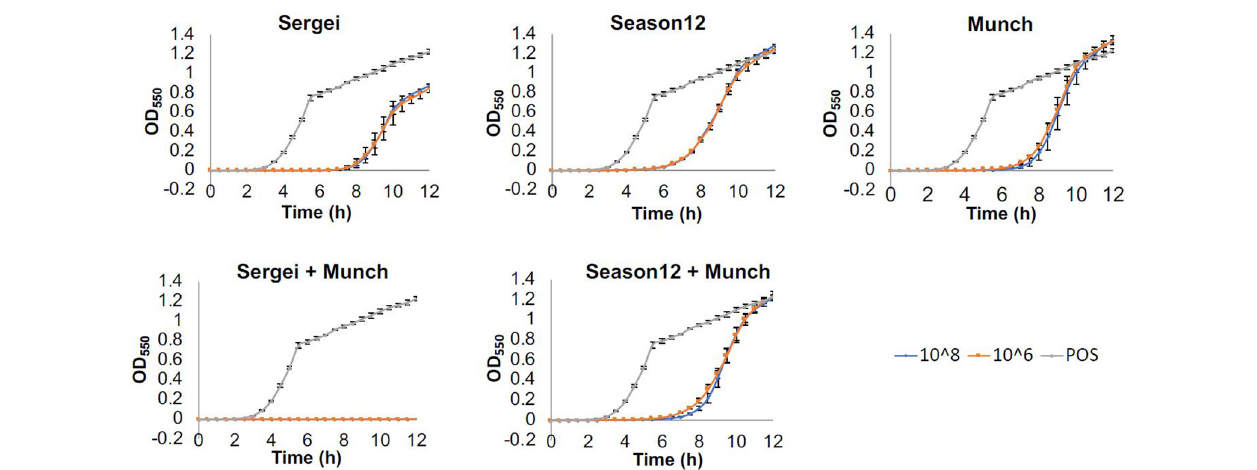
FIGURE 2 | Efficacies of phages alone and in combination against S. Anatum FC1033C3 in a microtiter-plate based assay. Wells of 96-well microtiter plates were inoculated with bacterial culture ( ∼ 10 5 CFU/mL) and challenged with single phages or phage mixtures at concentrations of 10 8 or 10 6 PFU/mL, and growth was monitored by measuring OD 550 nm at 30-min intervals for 12 h. Growth curves were achieved by plotting OD after baseline adjustment against time. Three biological replicates were performed for each assay. Blue, orange and gray curves represent growth profiles of phage treatments at 10 8 PFU/mL, phage treatments at 10 9 PFU/mL and positive (no phage) control.